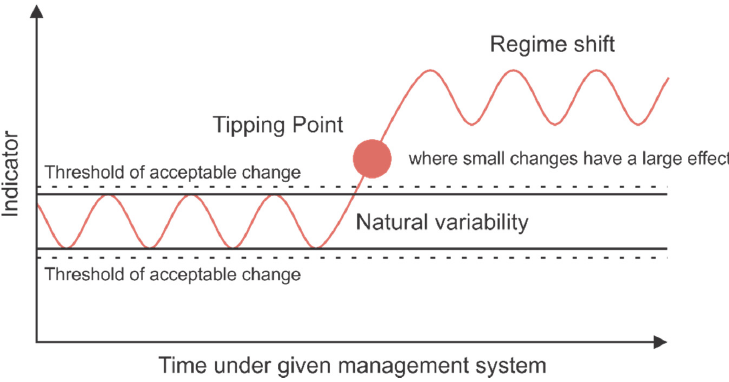
Figure 5. Concepts of thresholds, tipping points and regimes shifts into forest management strategies.